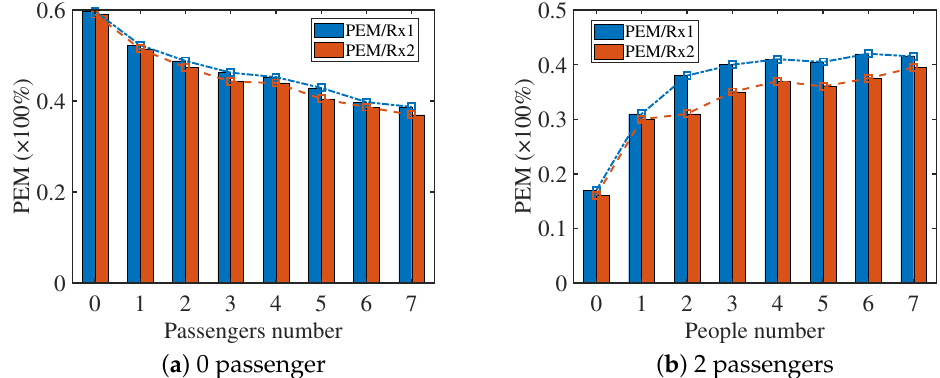
Figure 8. Comparison of the variation of PEM in two scenes. ( a ) In the elevator. ( b ) In the